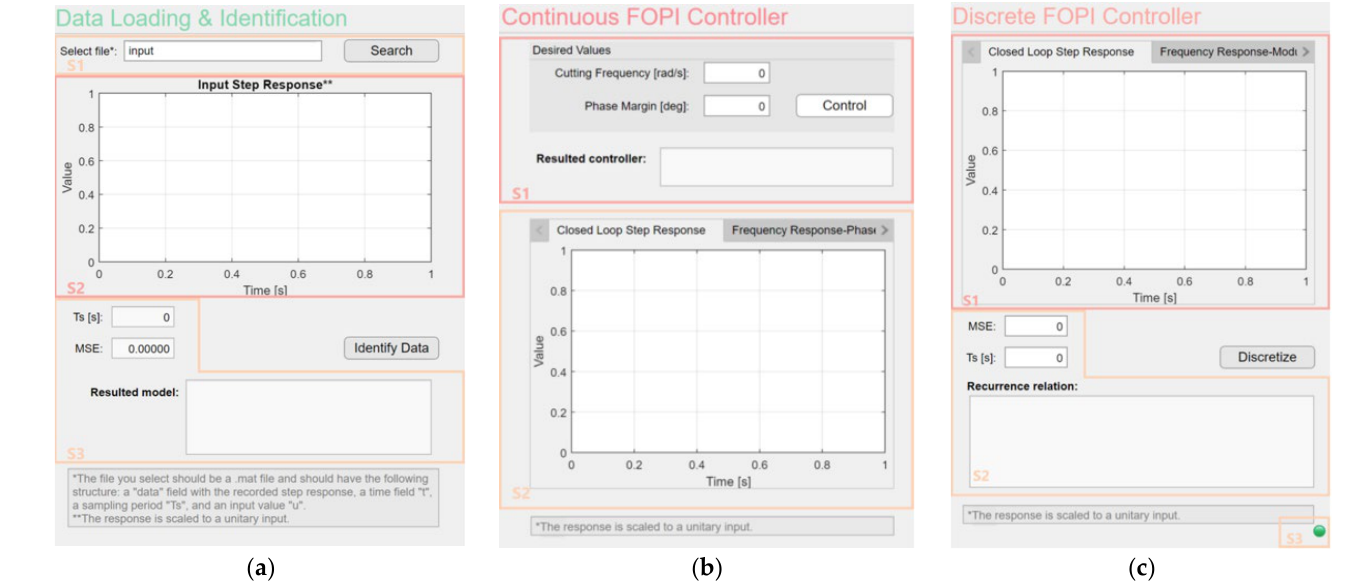
Figure 4. ( a ) Identification Section, ( b ) FOPI controller design Section, ( c ) Discrete-time FOPI con- troller Section.